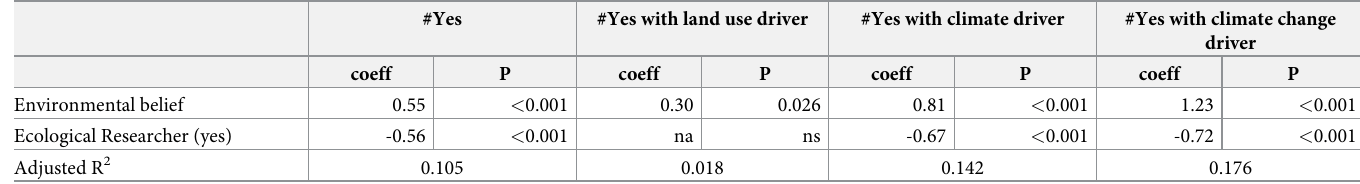
Table 3. Best statistical models to explain responses to Part 1 multiple-choice questions using Part 3 demographic explanatory variables.